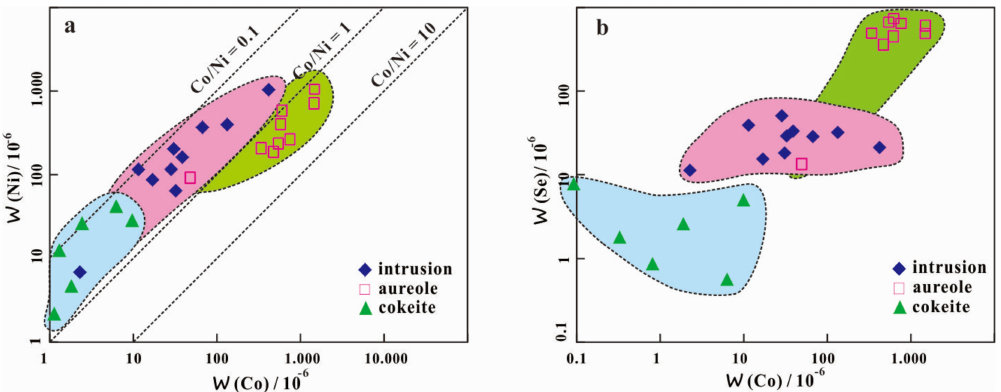
Figure 5. Binary diagrams of Ni, Se versus Co contents for different pyrite from the Yuandian Coal Mine. ( a ) Ni versus Co contents for different pyrite; ( b ) Se versus Co contents for different